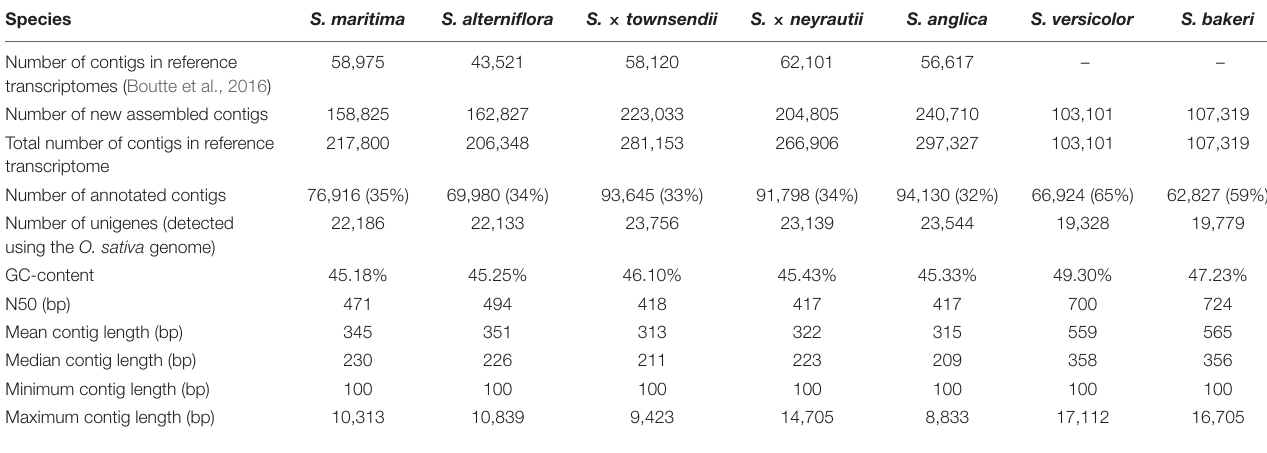
TABLE 2 | Spartina reference transcriptomes and functional annotations.